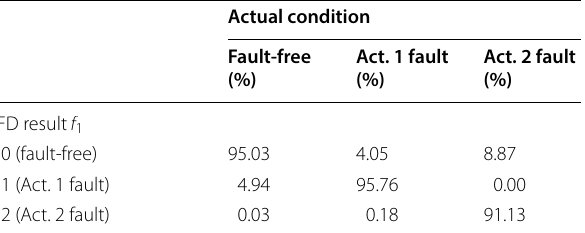
Table 2 FD accuracy rate (about f 1 ) Actual condition